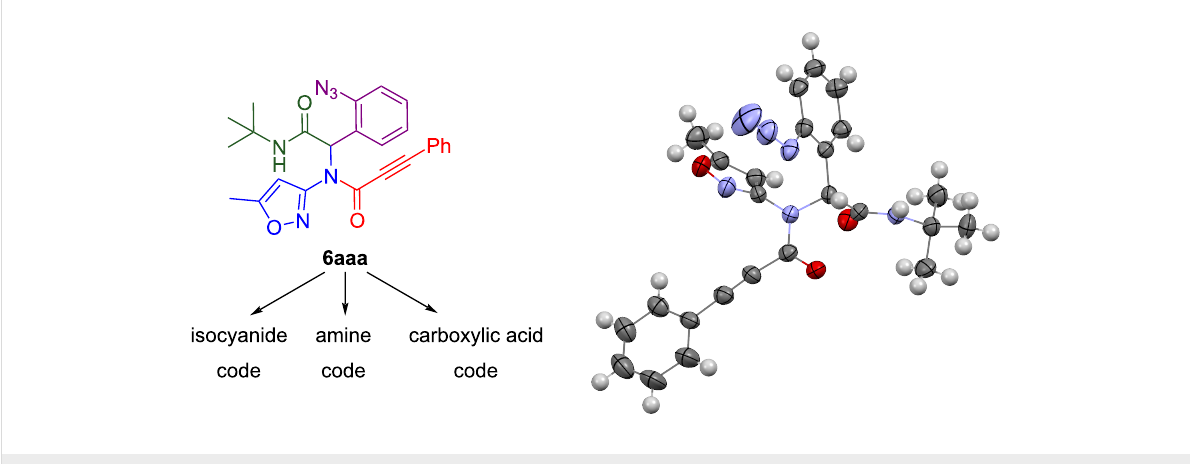
Figure 3: Code legend for Ugi products 6 and molecular structure (X-ray analysis) of compound 6aaa .